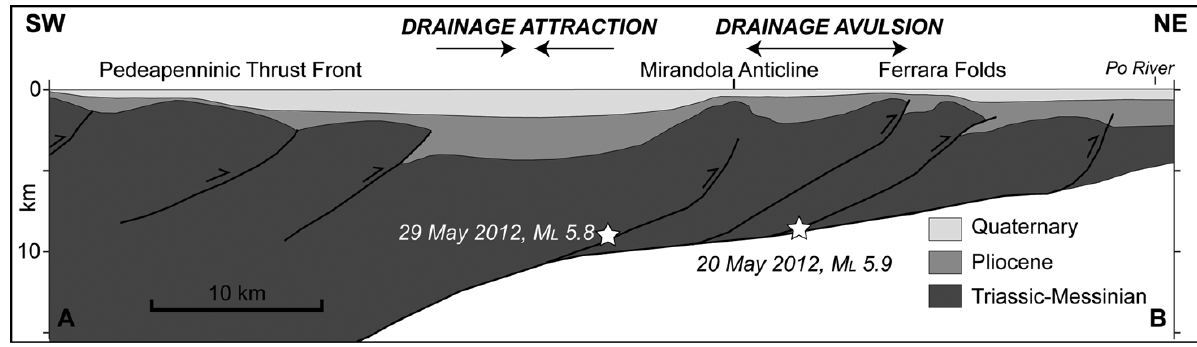
Figure 3. Simplified SW-NE geological section across the northern Apennines thrust fronts in the epicentral area of the 2012 Emilia-Romagna seismic se- quence [redrawn after Carminati et al.